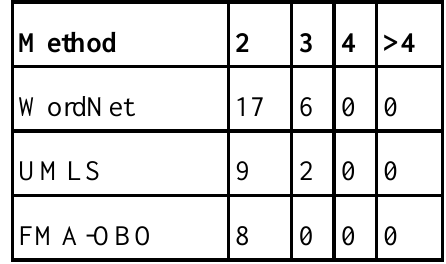
Table 3A: Ambiguity of predictions. Mouse terms mapped to 2 or more zebrafish